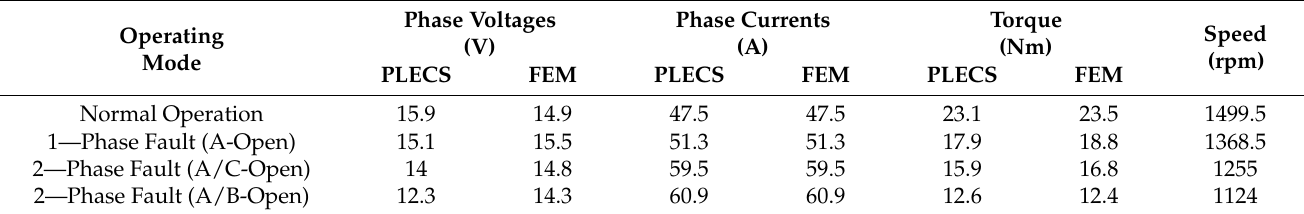
Table 5. Numerical output modeling